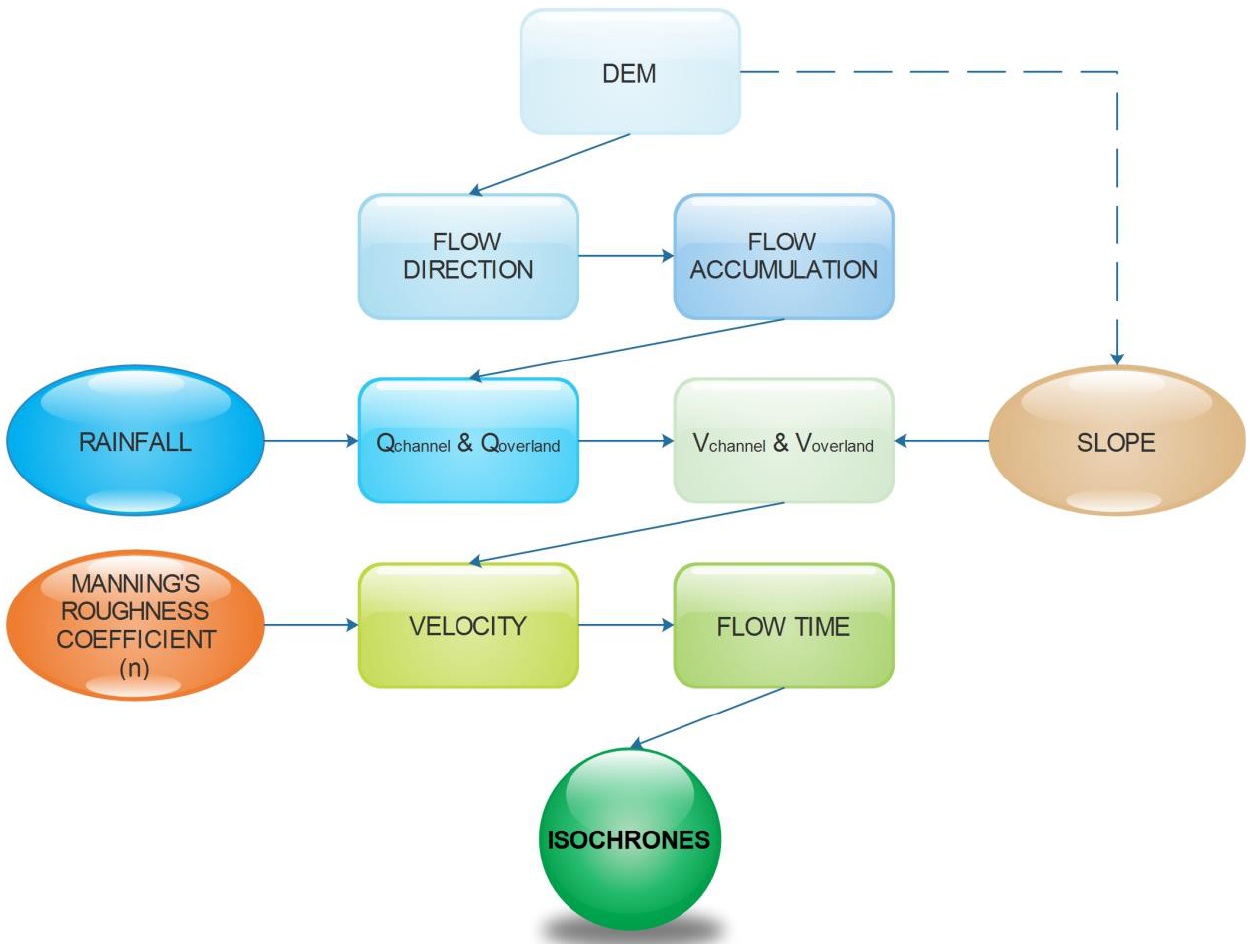
Figure 3. The flow chart of the methodology (Q channel , Q overland , V channel and V overland are the discharge within the channel, the overland discharge, the velocity within the channel and the overland velocity of the water, respectively).